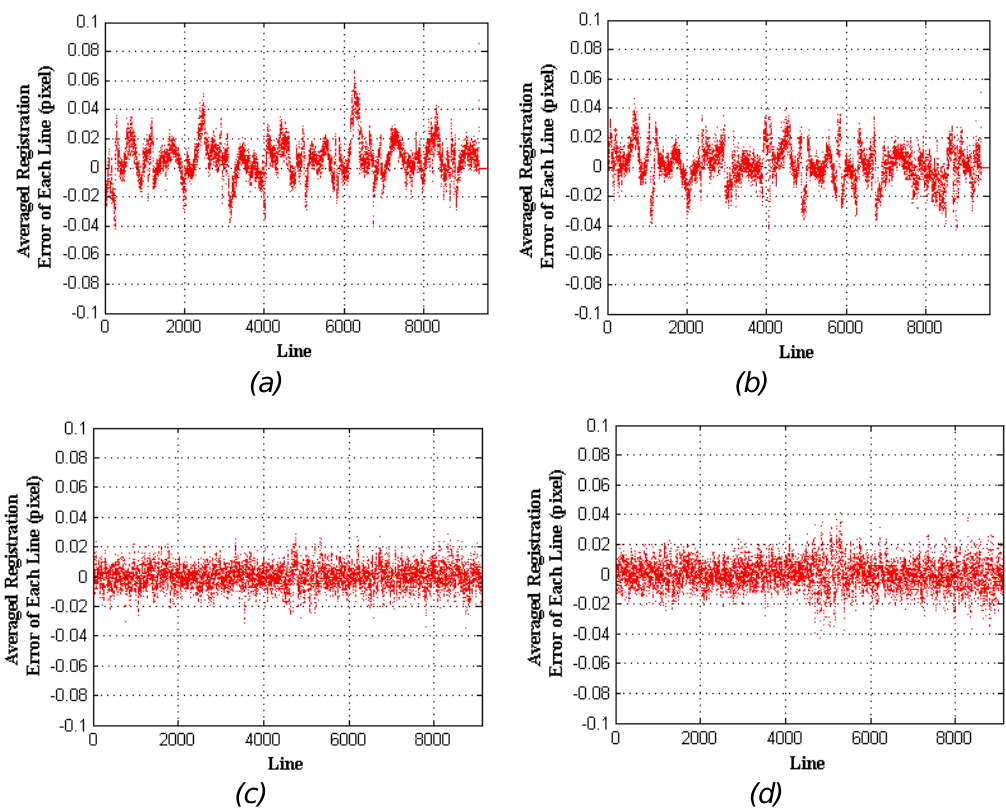
Figure 7. The jitter detection curve after compensation, (a), (c), are error curves in sample direction of dataset 1, 3; (b) (d) are error curves in line direction of dataset 1, 3.